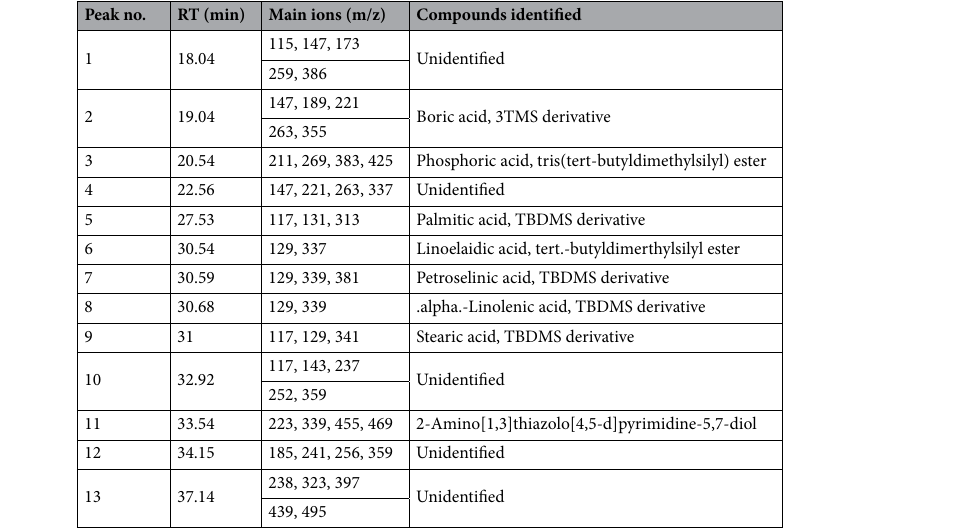
Table 2. GC/MS analysis result of modern tea residue and sample